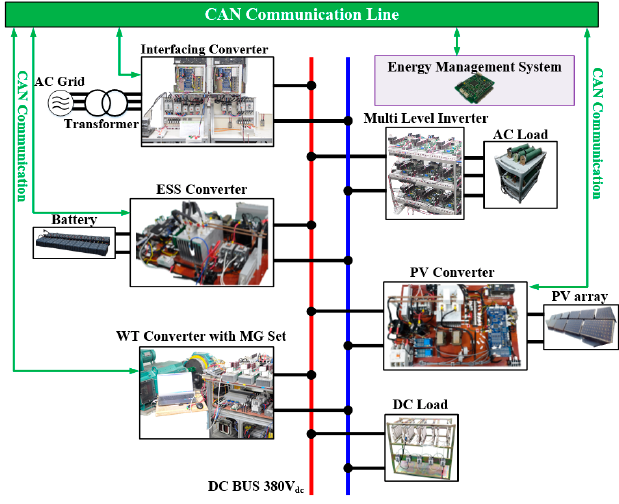
Figure 7. Experiment configuration of DC microgrid.